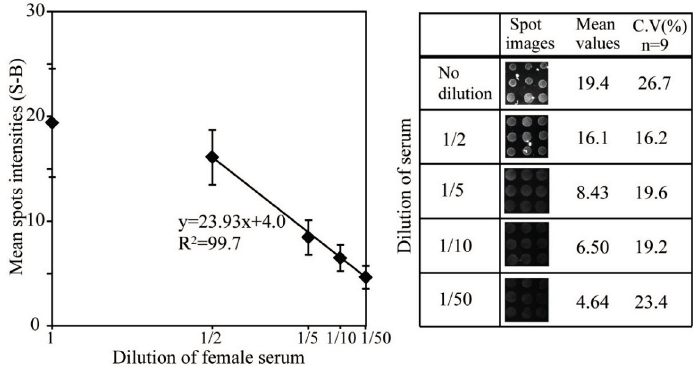
Figure 5. Immunoassay signals of the diluted serum samples. Serum samples were diluted down to 50 times and the samples were immunoassayed on microarray chips. The concentration of capture antibody was 100 µg/mL. Mean spot intensities and coefficients of variant are presented with spot images in the left